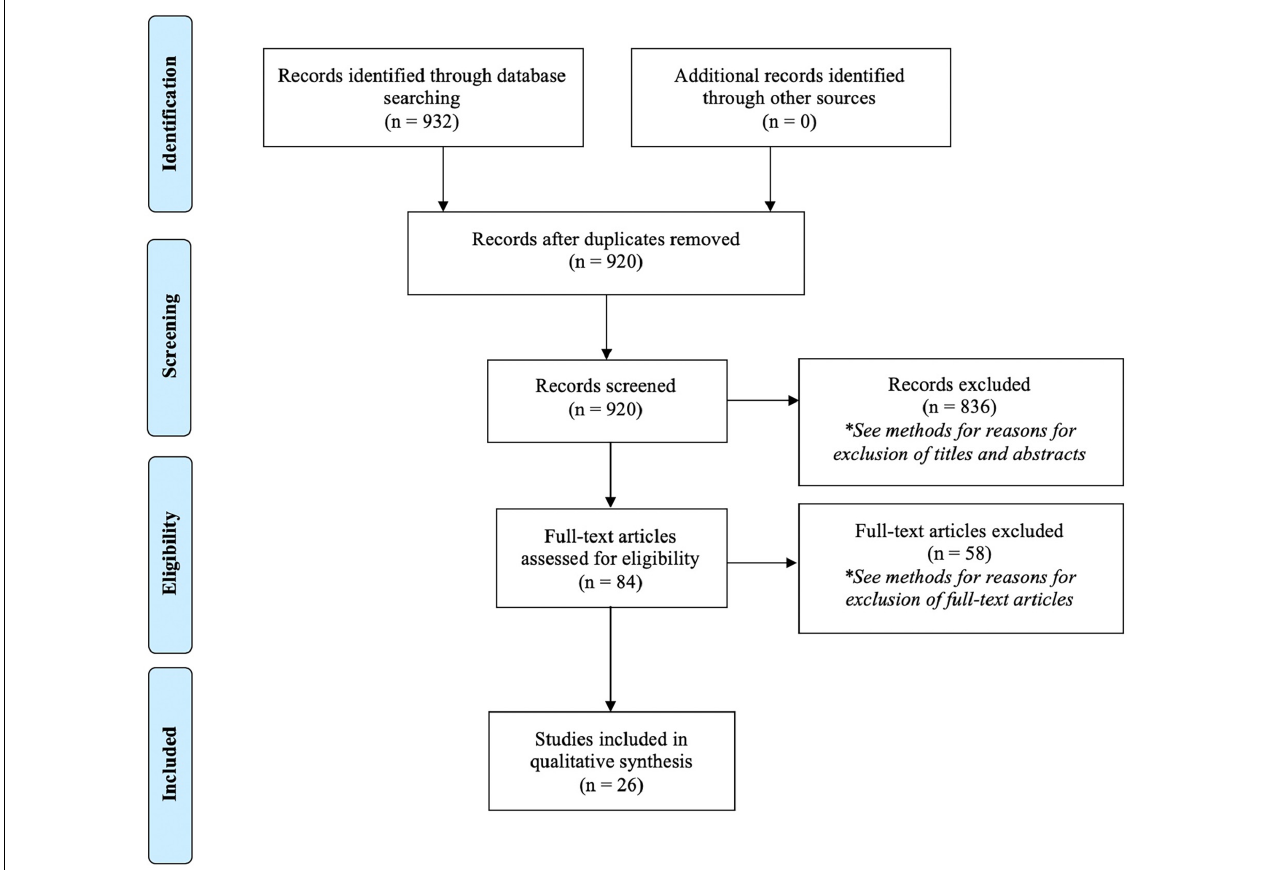
FIGURE 1 | PRISMA flow diagram delineating the search for literature completed through October